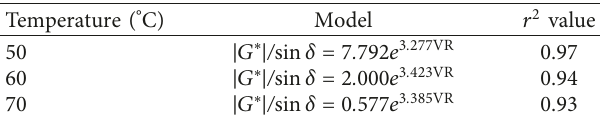
G / sin δ and VR for the limestone- | | ∗